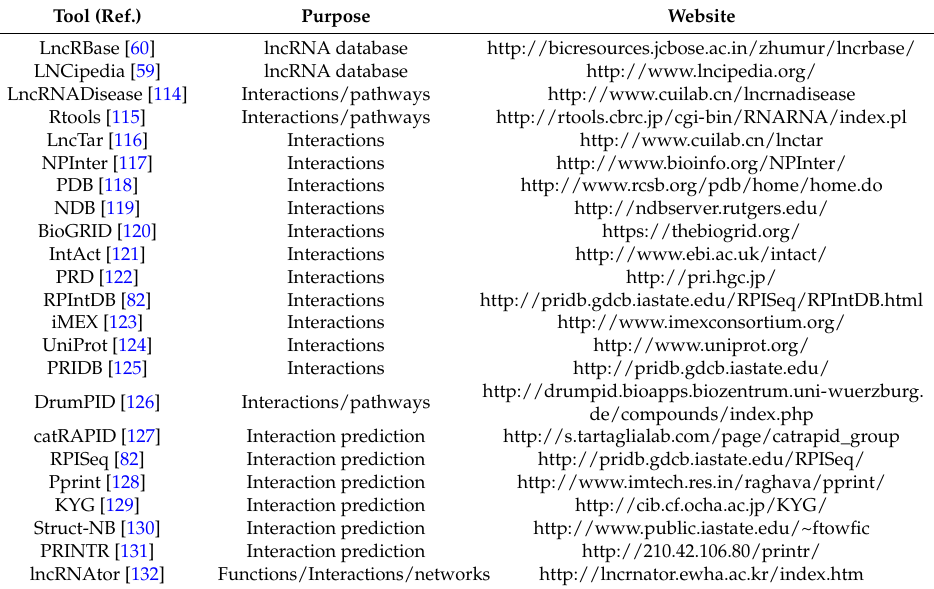
Table 5. Databases and software packages for lncRNA research. Tool